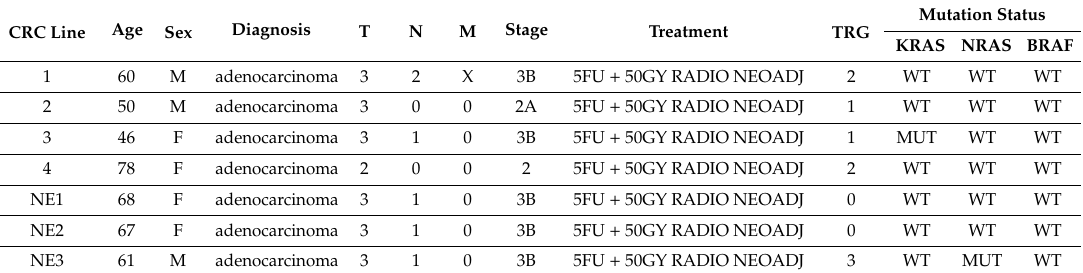
Table 2. Clinical characteristics of the patients enrolled. Patients for whom cell lines were not obtained are reported with gray